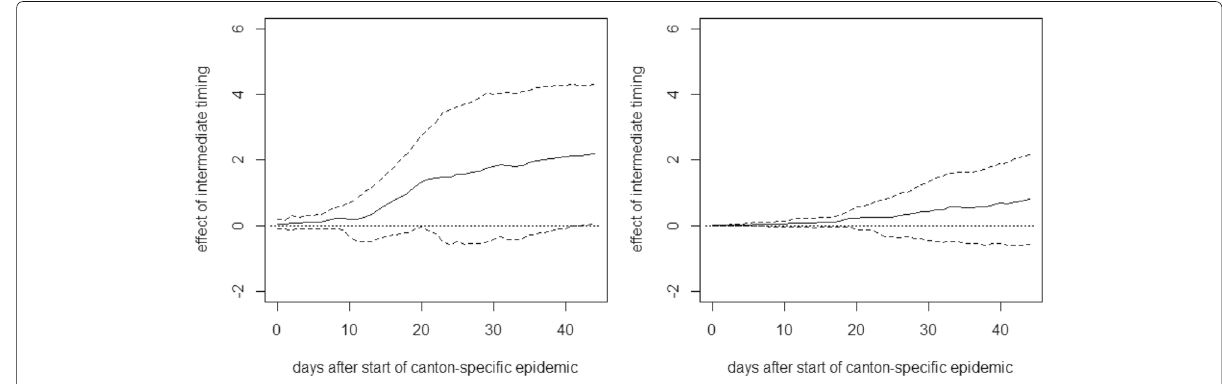
Fig. 8 Effect of intermediate timing of measures on cumulative hospitalizations (left) and deaths (right) per 10,000 inhabitants